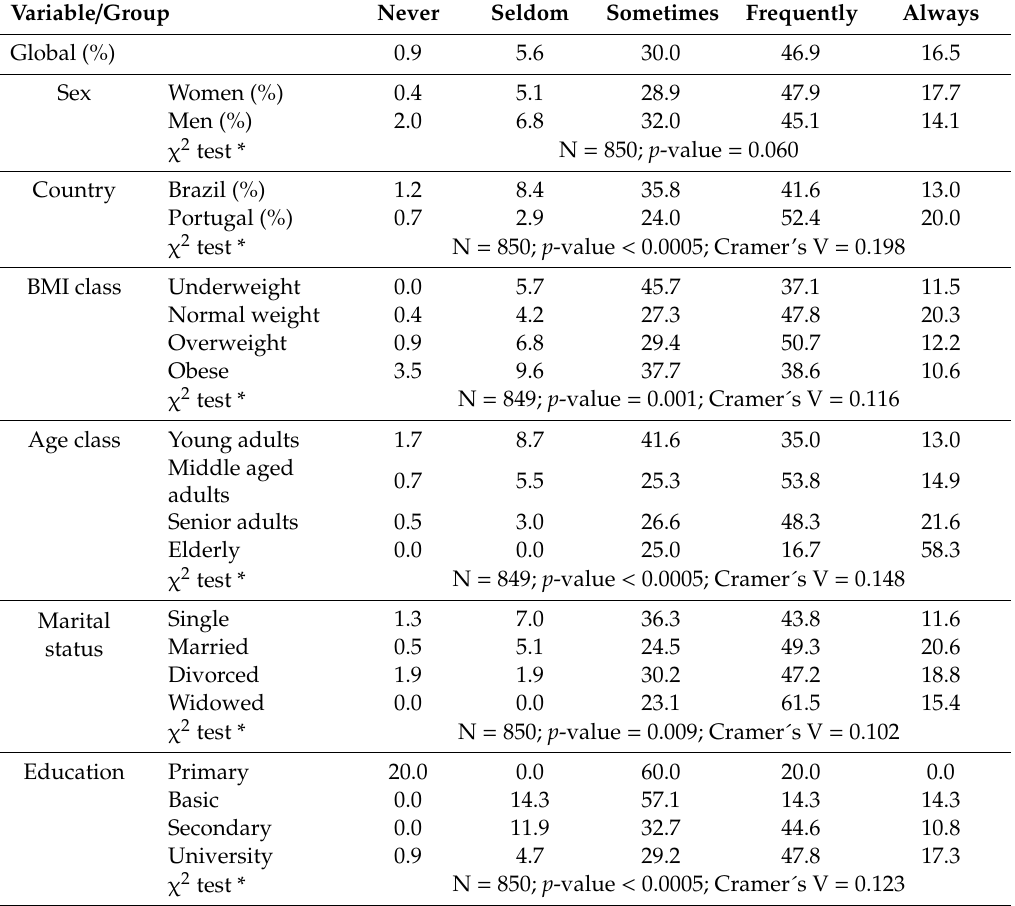
Table 4. Practice of a balanced